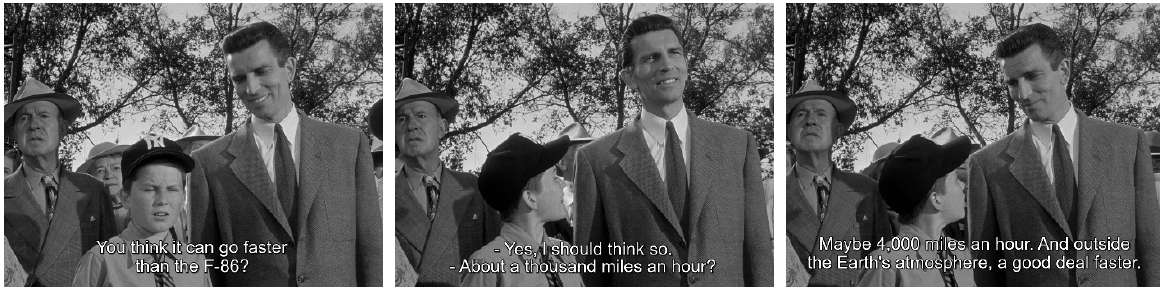
Figure 6. Klaatu’s smug countenance. The Day the Earth Stood Still © 20th Century Fox. All Rights Reserved.